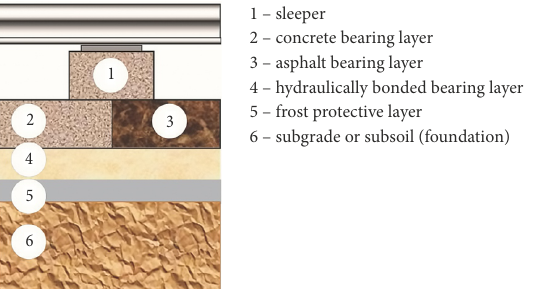
Construction of prepared formation layer using ash with activators (cement or lime), for new designed Fig. 9. The stabilization of soft subsoil and construction of embankments using soil stabilized with ash and construction of embankments with the core of ash (left side), and construction of prepared formation layer using ash with binders (right side)